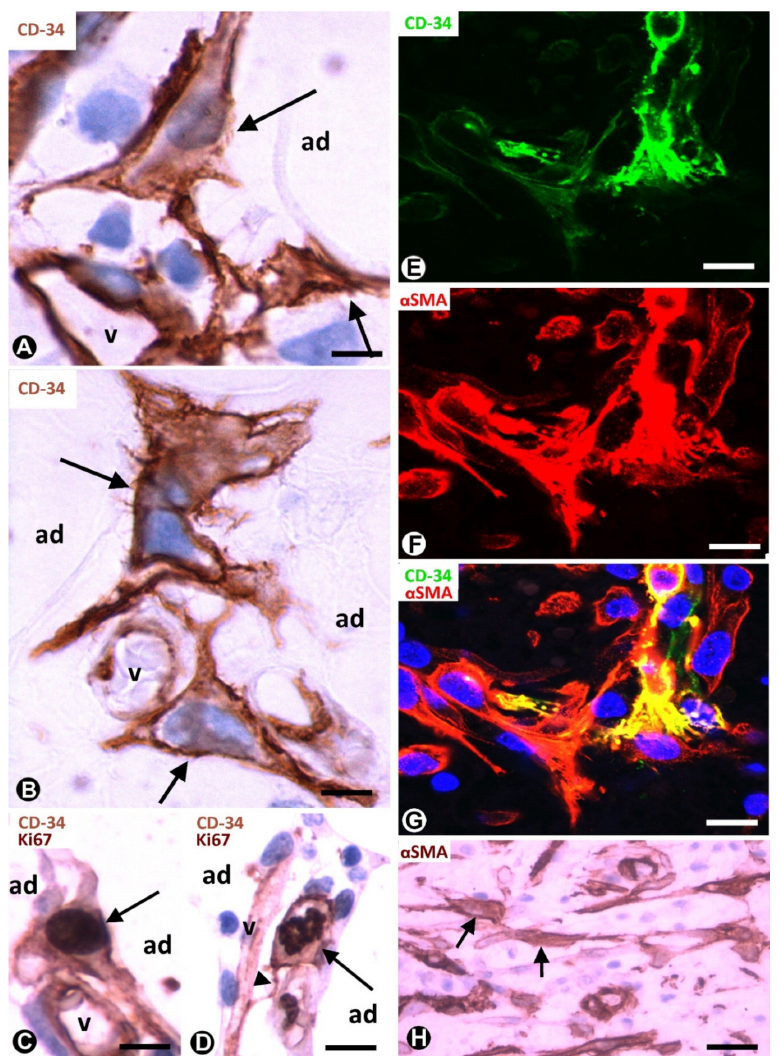
Figure 2. TCs / CD34 + SCs of the adipose tissue in early ( A – G ) and most advanced ( H ) stages of repair through granulation tissue. ( A , B ): bulky TCs / CD34 + SCs (arrows) with enlarged nuclei are observed around small vessels (v) and adipocytes (ad). ( C ): the co-expression of CD34 and Ki-67 in a TC / CD34 + SC (CD34 express in the membrane and in the periphery of cytoplasm, and Ki-67 in the nucleus) (arrow). ( D ): the co-expression of CD34 (in the membrane and peripheral cytoplasm) and Ki-67 (in chromosomes) is shown in a TC / CD34 + SC in mitosis (arrow). Note in this cell a thin process (telopode, arrowhead) in contact with a capillary (v). ( E – G ) the co-expression of CD34 (green) and α SMA (red) in stromal cells. H: stromal cells expressing α SMA are present in an advanced stage of repair. A and B: immunochemistry for CD34. ( C , D ): sections are doubly immunostained with CD34 and Ki-67 (CD34 stained the cell membrane and peripheral cytoplasm, and Ki-67 the nucleus). ( E – G ): confocal microscopy, frontal view, immunofluorescent label with anti-CD34 (green) andanti- α SMA(red). ( H ):immunochemistryfor α SMA.Haematoxylincontrastin( A – D , H ).DAPI (blue) counterstain in G. Bar: ( A , B ): 10 µ m; ( C – G ): 20 µ m; ( H ): 40 µ